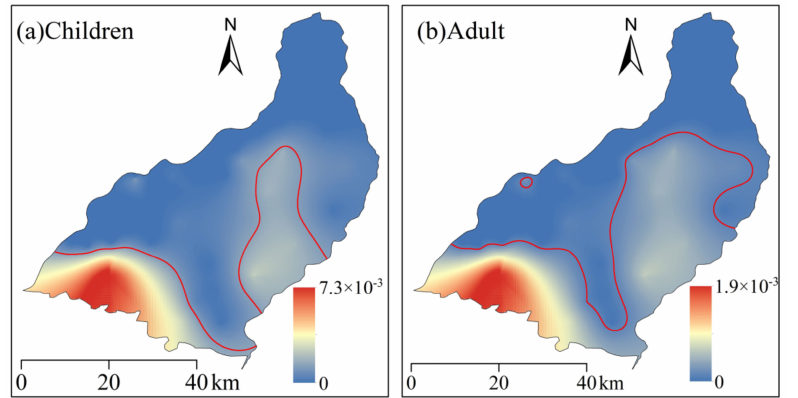
Figure 11. Carcinogenic risk zoning map of the Shizuishan area. The red line represents the risk threshold for R AS